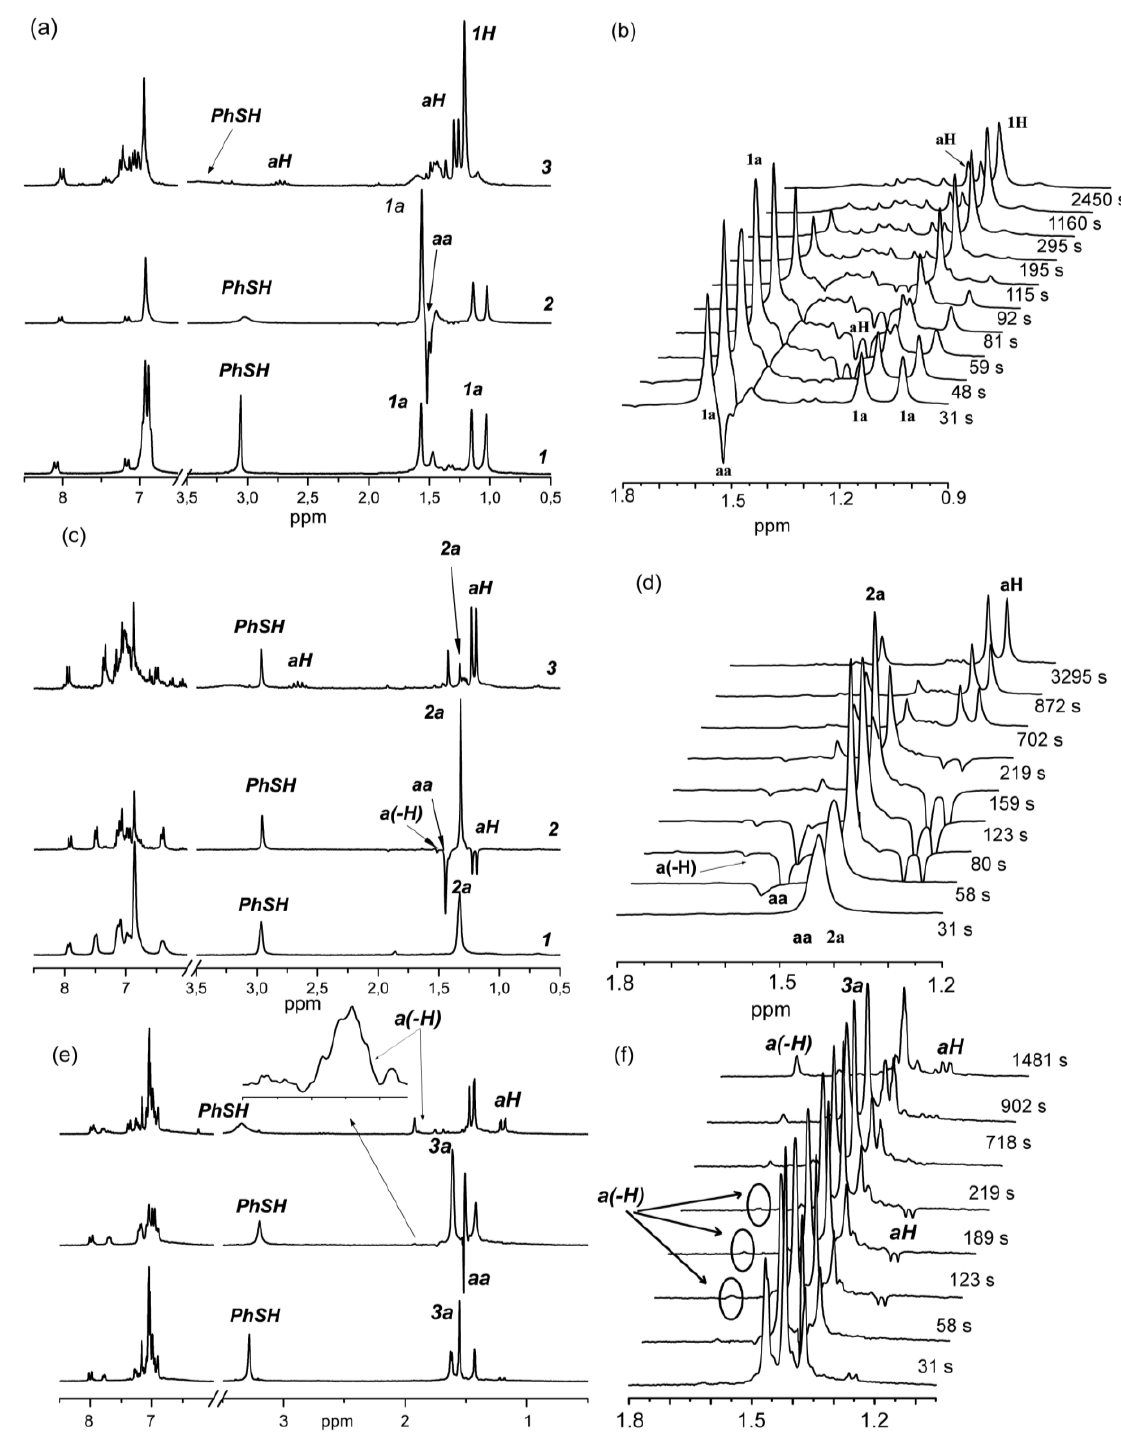
Figure 1. 1 H NMR spectra recorded at room temperature before (1) and after (3) thermolysis of 1a (a), 2a (c) in FSol and 3a (e) in m -C signals obtained during the thermolysis (2). 1 H NMR spectra recorded at different time intervals from the beginning of the reaction during thermolysis of 1a (b) at 398 K, 0.02 M solution of alkoxyamine in FSol, 5.5 eq of thiophenol, 2a (d) at 386 K, 0.02 M solution of alkoxyamine in FSol, 3 eq of thiophenol, 3a (f) at 386 K, 0.02 M solution of alkoxyamine in m -C D Cl , 6 eq of thiophenol. Signs of polarization: E — aa , a(-H) , aH ; A — 1a–3a. 6 4 2 Inset: enlargement of the chemical shift zone for a(-H) of